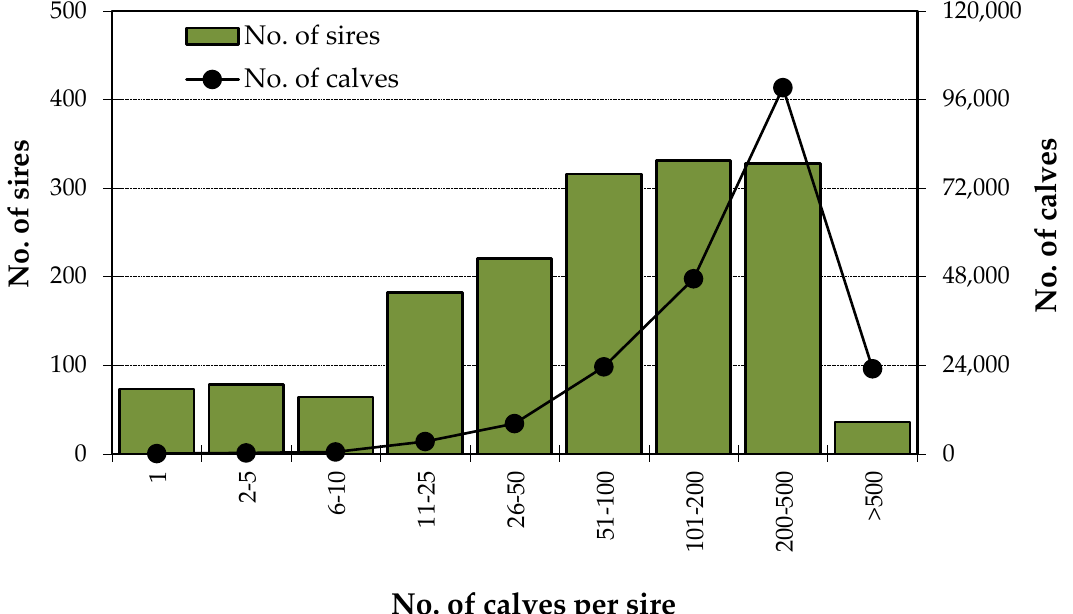
Figure 5. Number of sires and calves, by classes of number of calves per sire.